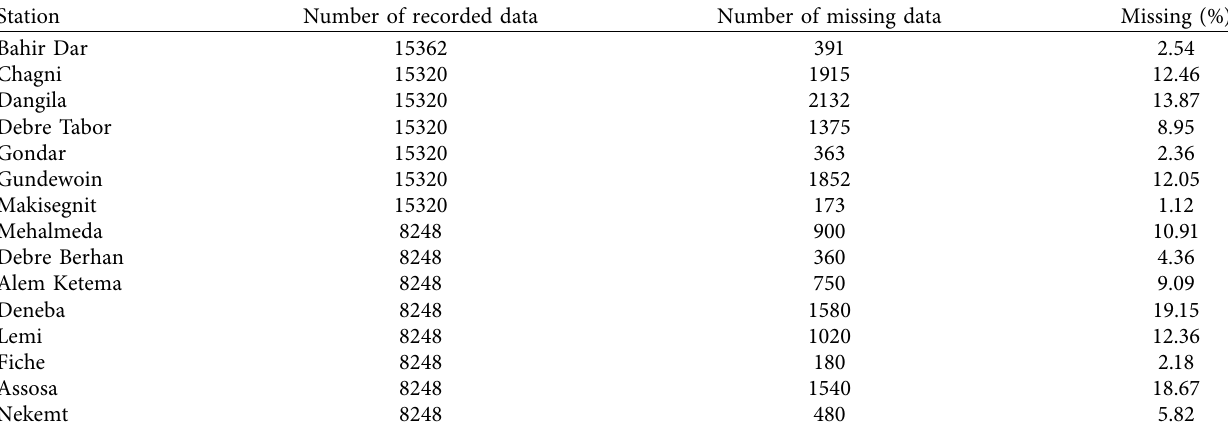
Table 2: Percentage of missing rainfall data for selected gauge station in the Abbay river